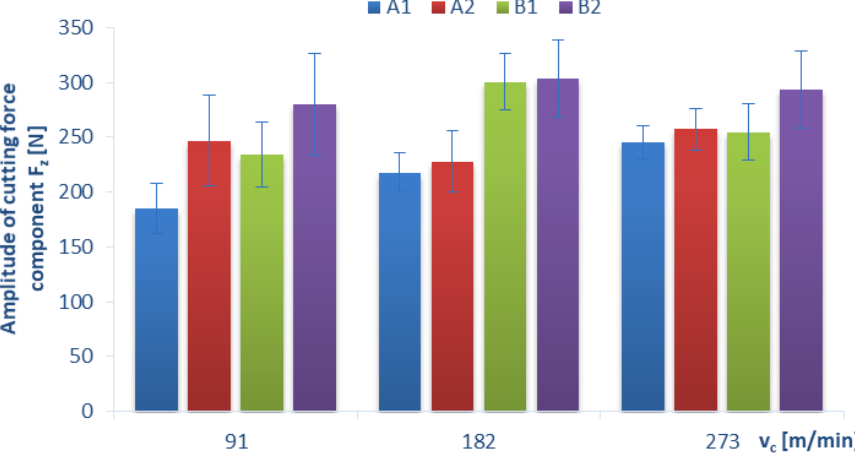
Figure 12. Relation between amplitude of cutting-force component F y and cutting speed v c , with constant feed per tooth f z = 0.16 mm/tooth for different GFRP materials.